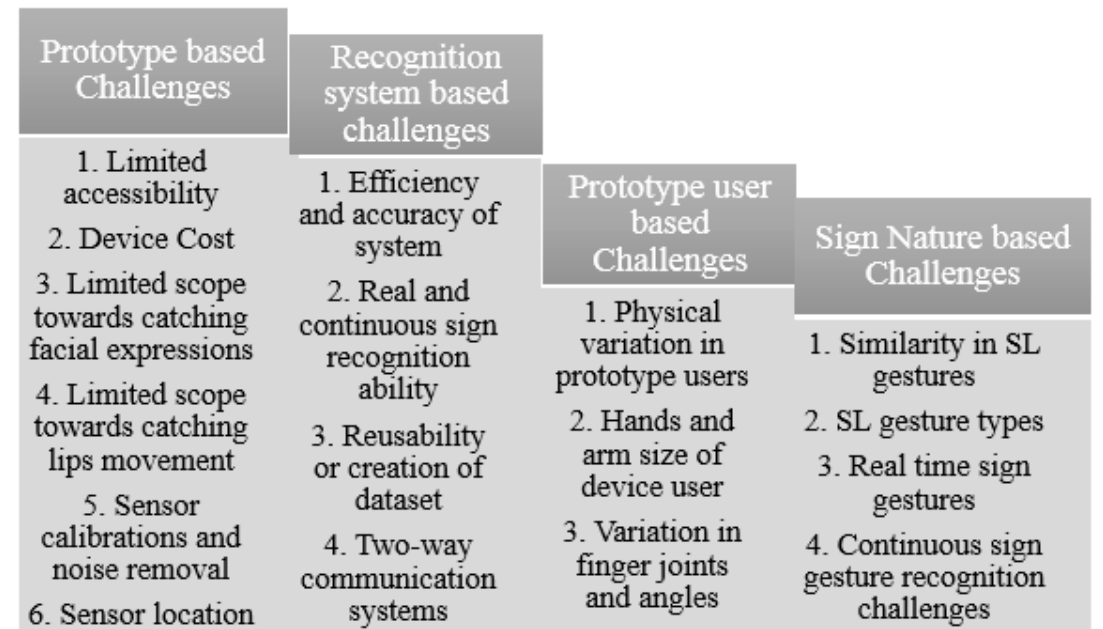
Figure 20. Key points of challenging domains of sign language models.